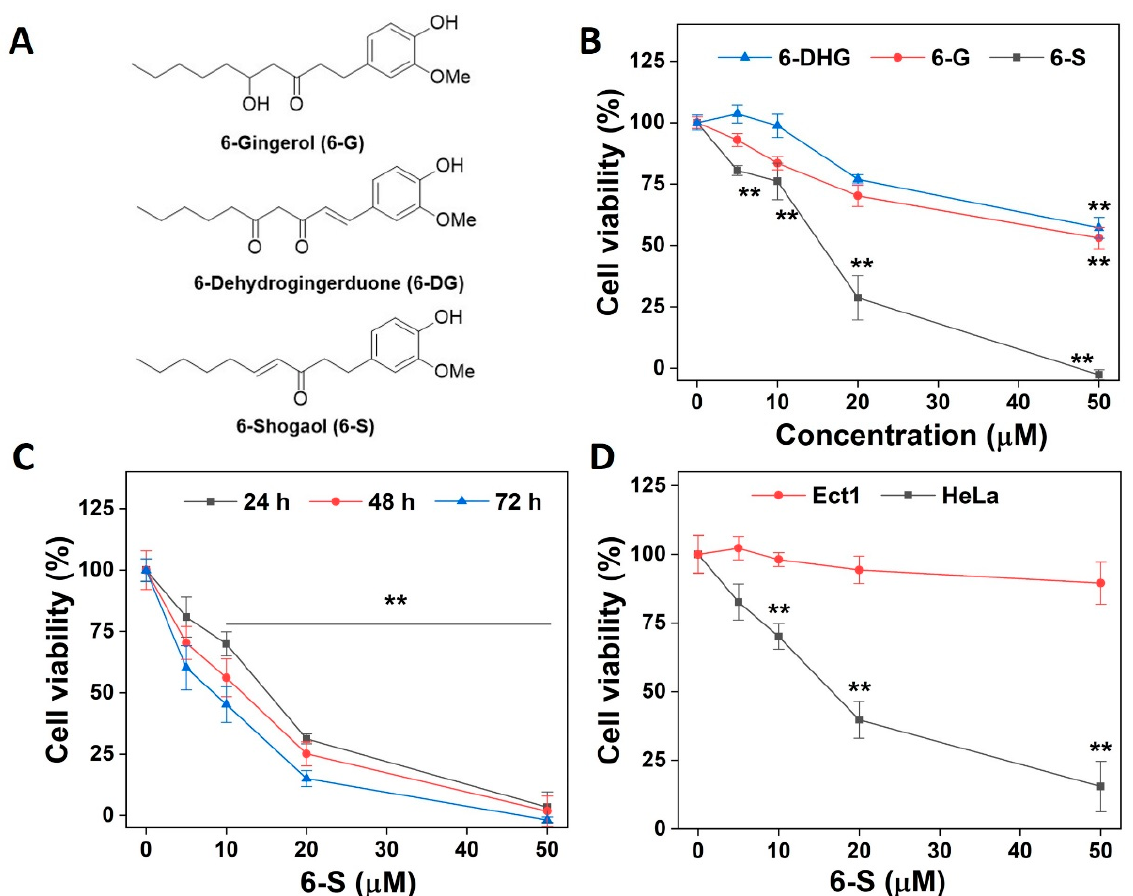
Figure 1. Induction of cell death by 6-S. ( A ) The chemical structure of 6-G, 6-DG, and 6-S. ( B ) Effect of 6-G, 6-DG, or 6-S on the cytotoxicity of HeLa cells. The cells (5 × 10 3 /well) were treated with the indicated concentrations of compounds for 24 h, and the cell viability was determined by the MTT assay. ( C ) Sensitivity of HeLa cells to 6-S. The cells (5 × 10 3 /well) were treated with 6-S for the indicated time, and the viability was determined using the MTT assay. ( D ) Cytotoxicity of 6-S in HeLa and Etc1 cells. The cells (1 × 10 4 ) were treated with 6-S for 48 h, and the viability was determined using the MTT assay. Data are expressed as the mean ± standard error of means of three experiments. **, p < 0.01 vs. the control group.